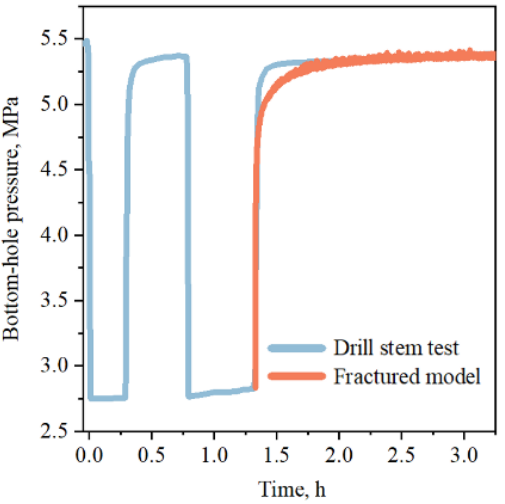
Figure 18. Comparison of the bottom-hole pressure from the gauge and the fractured model. Table 3. Input properties of the near-wellbore model for the Dalwogan 2 well.